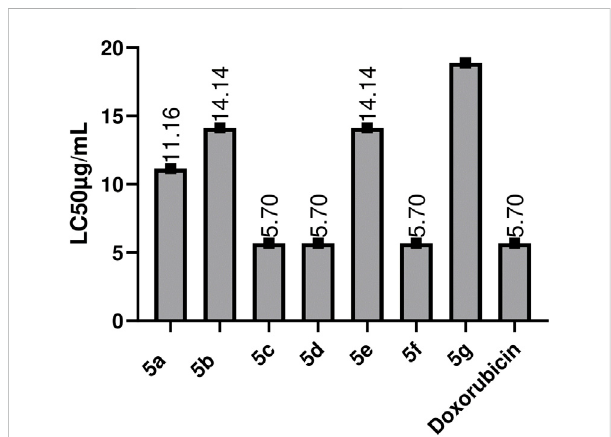
FIGURE 7 Toxicity evaluation of the synthetic compounds by using Brine shoxorubicin Values are expressed as Mean ± SEM(standard error of the mean, n = 3) lethality assay.